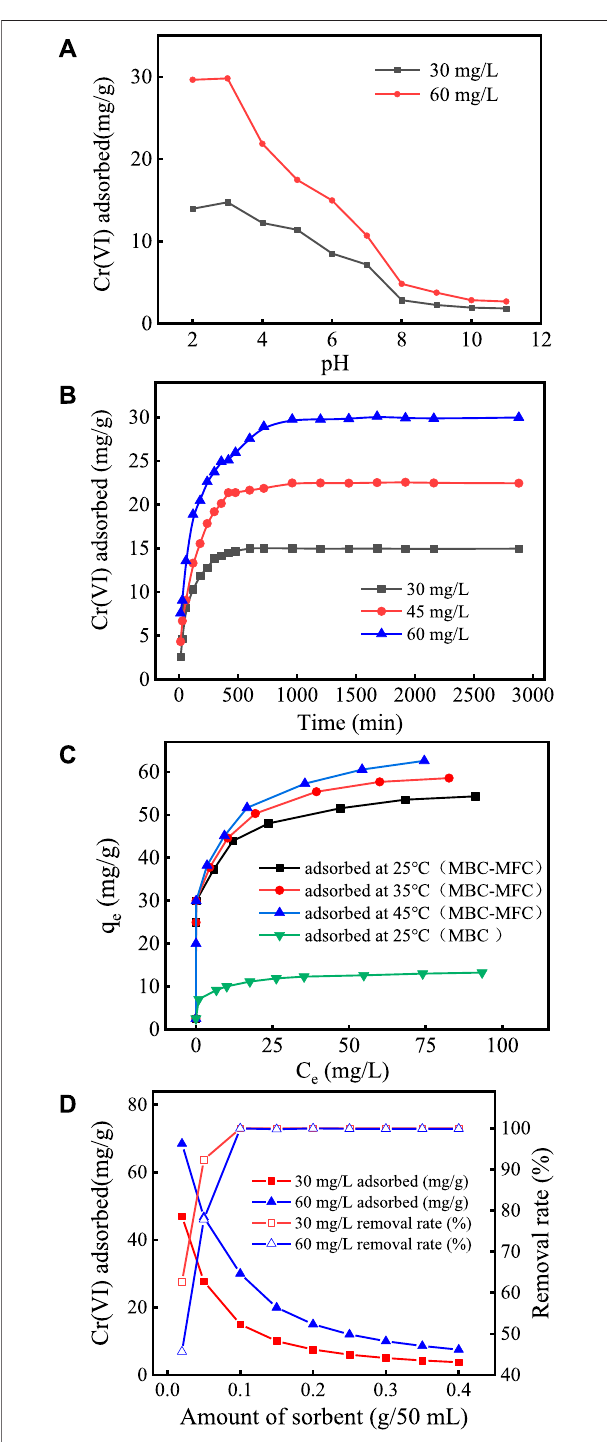
FIGURE 4 | Cr(VI) and T Cr removal of MBC-MFC. (A) Effect of pH. (B) EffectofcontacttimeatpH3.0. (C) EffectoftemperaturesatpH3.0. (D) Effect of dosage at pH 3.0.